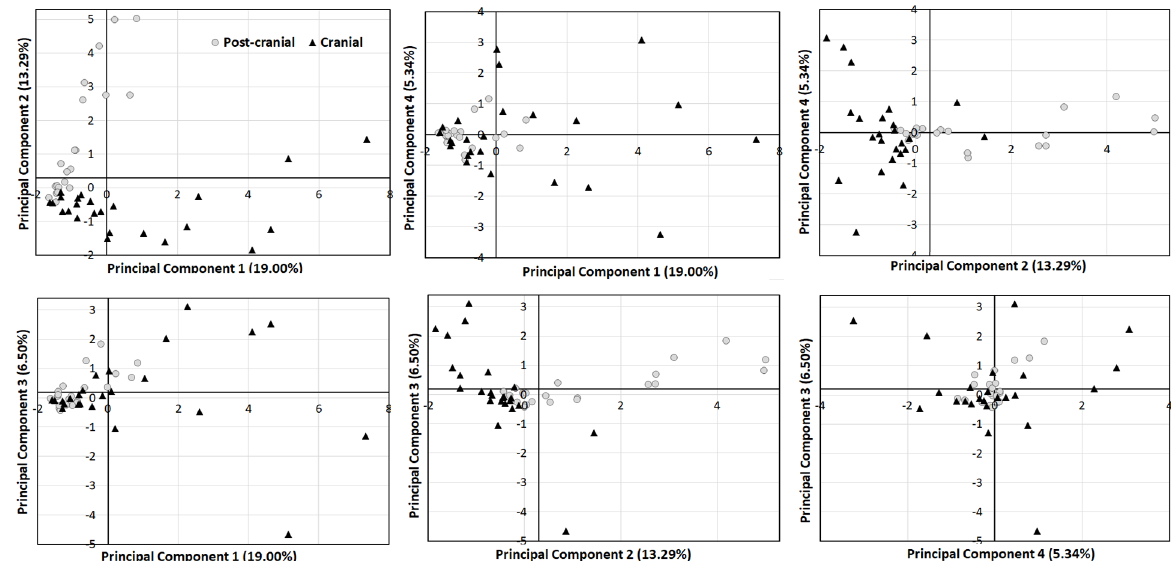
Figure 4. The six possible PCA scatter plot combinations for PC1 to PC4 of post-cranial (circle) and cranial (triangle) osteological features.